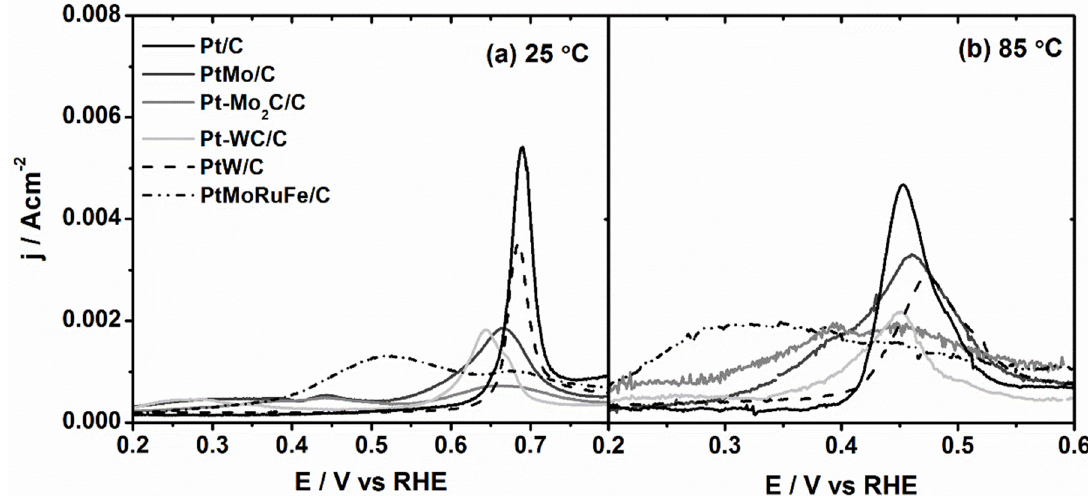
Figure 6 - CO stripping voltammograms for different anodic catalysts at 25 °C ( a ) and 85 °C ( b